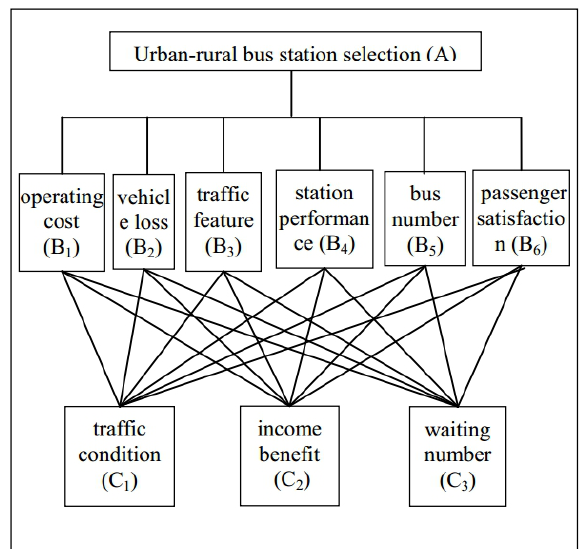
Figure 1. Analytic hierarchy process model